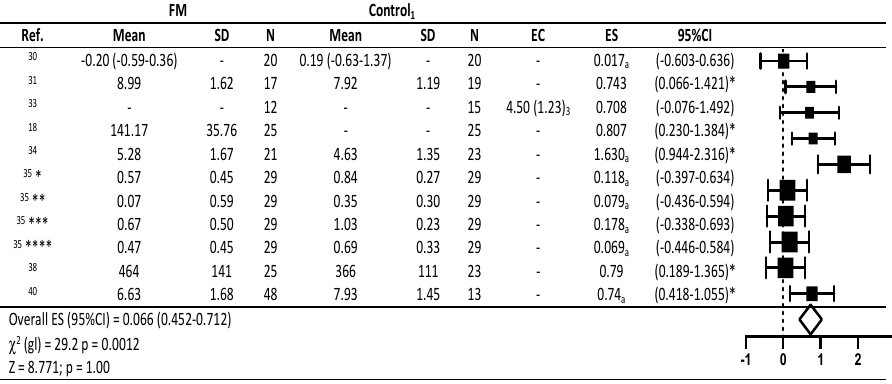
Figure 2. Descriptive statistics and forest plot of effects of fibromyalgia treatment interventions on cortisol levels. CS = contrast statistic; 1: comparison group, other treatment applied; 2: median (min- max) percentage change; 3: F (gl): Snedecor contrast F statistic (degrees of freedom); a: η 2: Eta squared;